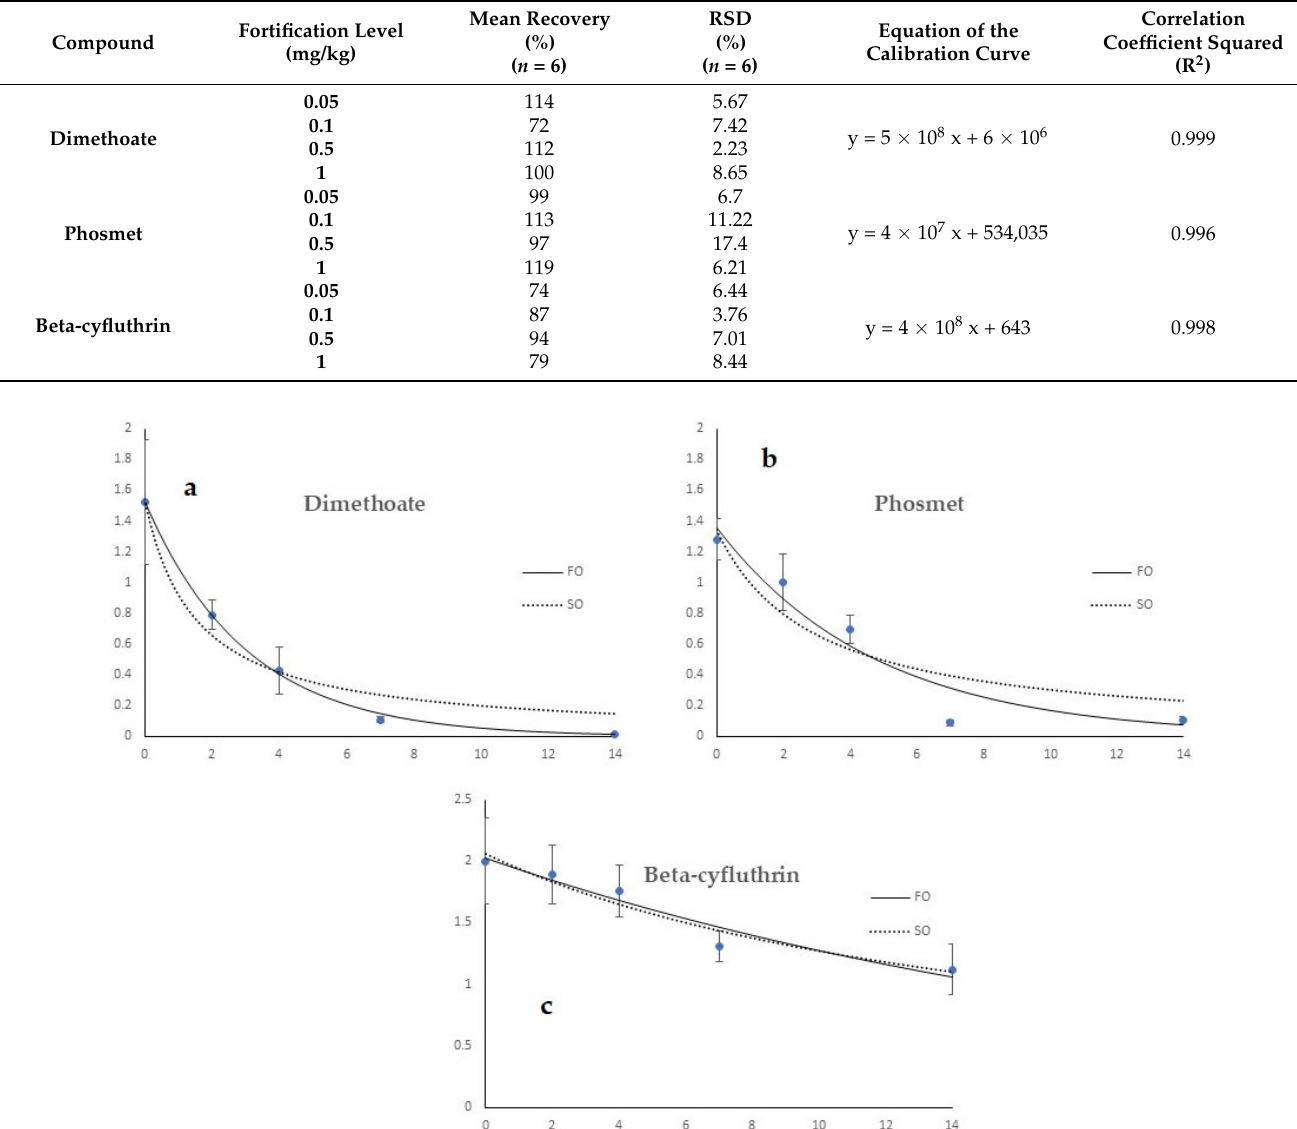
Figure 4. Changes in residual concentrations of dimethoate ( a ), phosmet ( b ) and beta-cyfluthrin ( c ), in olive leaves after determination as dislodgeable foliar residues. Solid and dashed lines indicate the results predicted using first-order (FO) and second-order kinetic models,